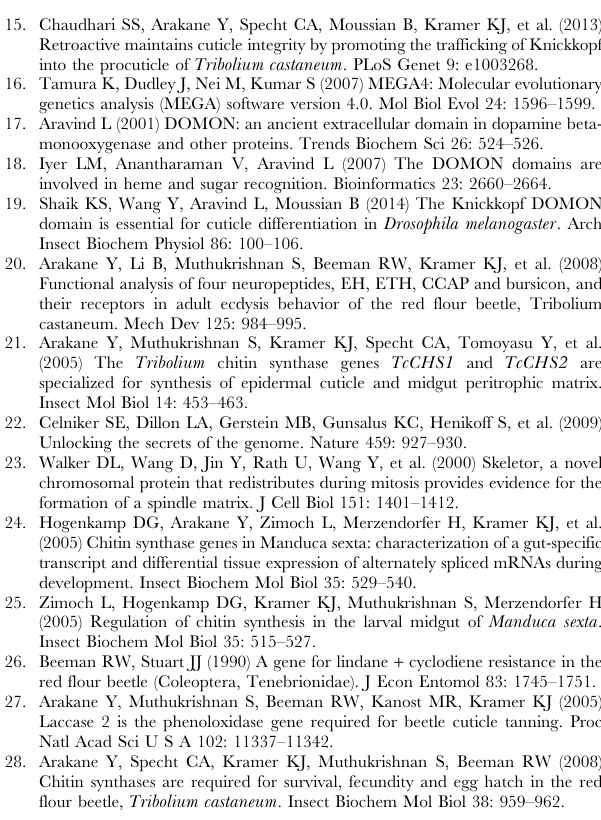
Table S2 Summary of phenotypes observed after